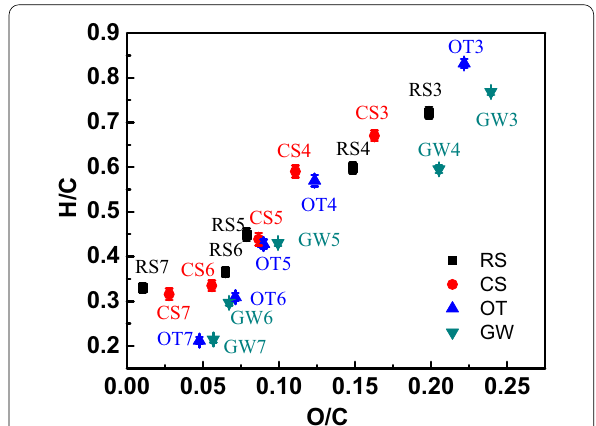
Fig. 1 Van Krevelen graph of biochar prepared with different